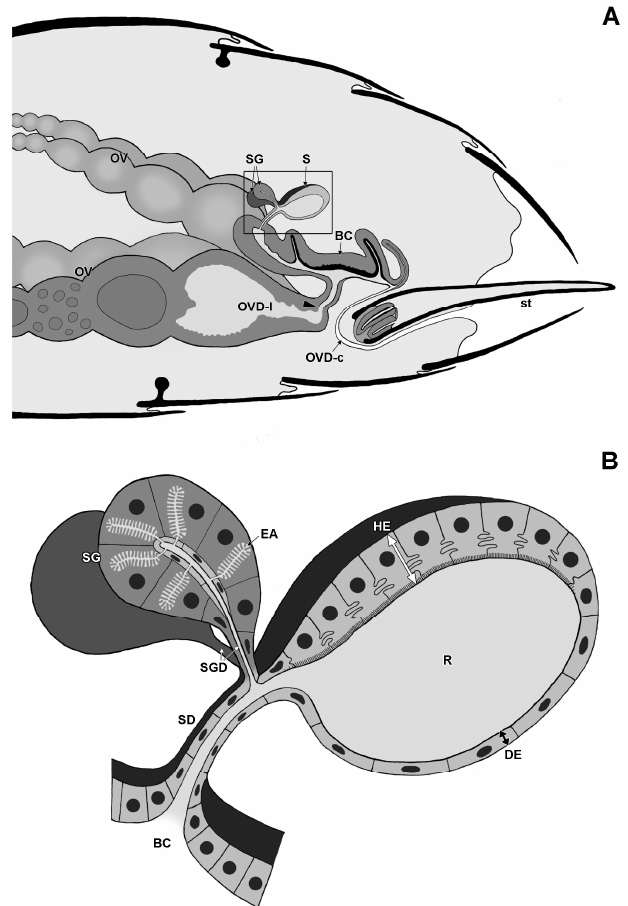
Figure 1. Schematic drawing of gaster with reproductive system ( A ) and spermatheca ( B ) in Stru- migenys queens. Note S-shaped oviduct when sting is in retracted rest position. BC: bursa copulatrix, DE: distal epithelium, EA: end apparatus, HE: hilar epithelium, OV: ovariole, OVD-l: lateral oviduct, OVD-c: common oviduct, R: reservoir, S: spermatheca, SD: spermatheca duct, SG: spermatheca gland, SGD: spermatheca gland duct, st: sting. Arrowhead indicates transition between common (cuticle-lined) and lateral (no cuticular lining) oviduct.